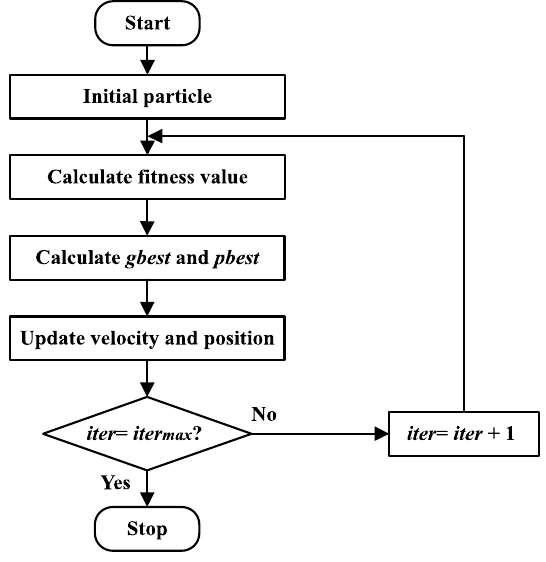
Figure 6. The flowchart of the particle swarm optimization (PSO) algorithm.